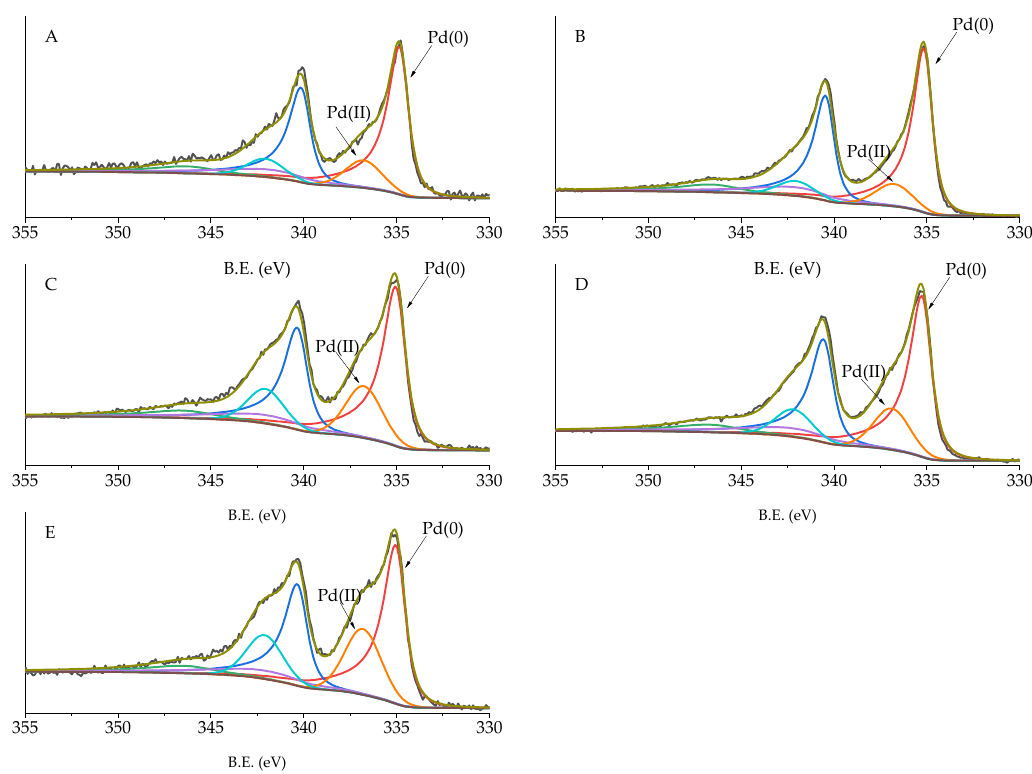
Figure 6. XPS of Pd 3d species for ( A ) Pd/KB_0.0, ( B ) Pd/KB_0.1, ( C ) Pd/KB_0.3, ( D ) Pd/KB_0.65, and ( E ) Pd/KB_1.2 catalysts.